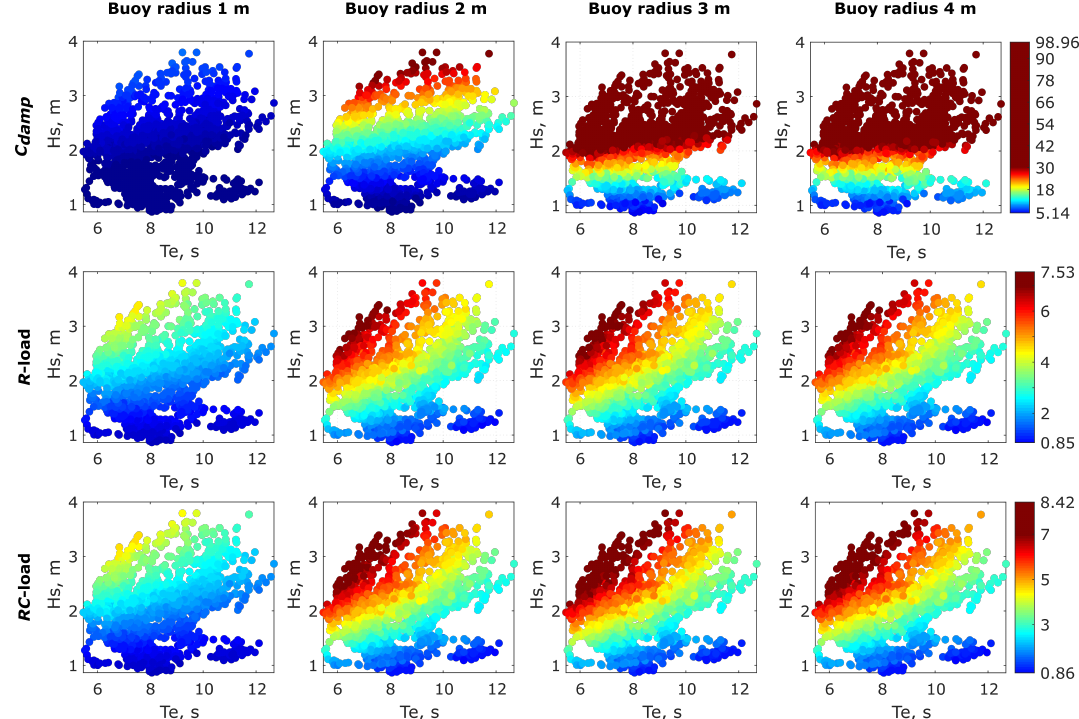
Figure 12. Absorbed power for the stiff connection case for March 2018. The colour bar shows the average absorbed power in